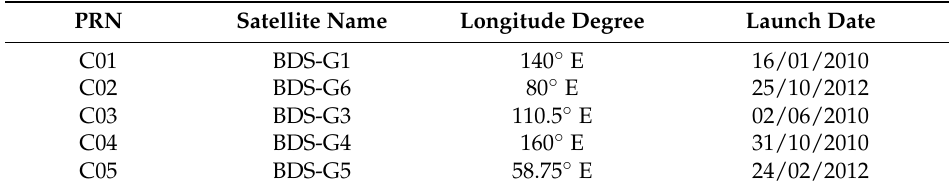
Table 1. Information on BeiDou Navigation Satellite System (BDS) geostationary earth orbit (GEO) satellites